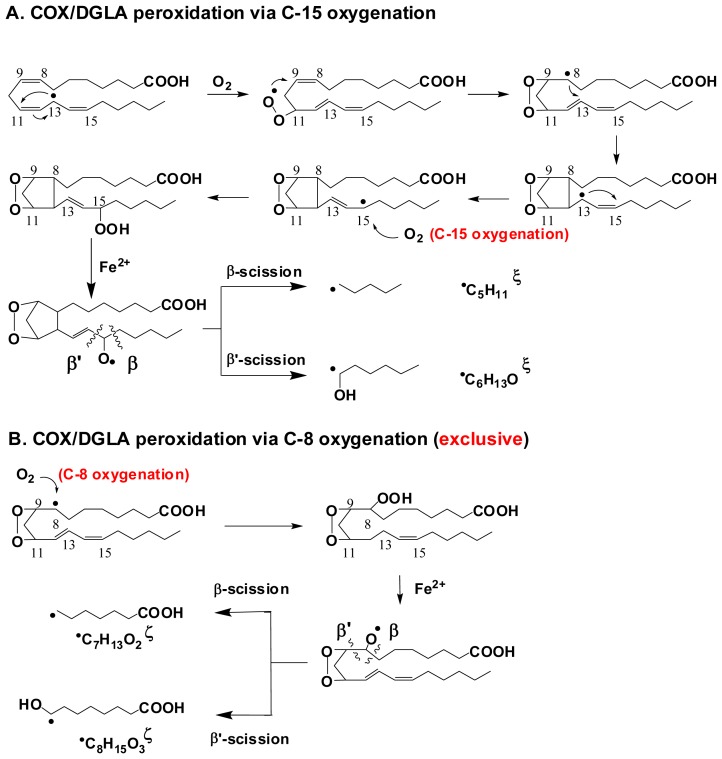
Proposed reaction pathways for COX-catalyzed DGLA peroxidation. (A) COX/DGLA peroxidation via C-15 oxygenation; (B) COX/DGLA peroxidation via C-8 oxygenation (the first two steps are the same as with C-15 oxygenation). The radical products (labeled with the corresponding molecular formulas) can be trapped by POBN, thus are screened by LC/MS as the radical adducts POBN/•C6H13O, POBN/•C5H11, POBN/•C8H15O3, and POBN/•C7H13O2 with m/z of 296, 266, 354, 324, respectively. ξ: Radicals common to COX/AA and COX/DGLA peroxidation. ξ: Radical exclusive to COX/DGLA peroxidation. All of the major radical products can be observed in both cell-free reactions and cellular experiments [71].